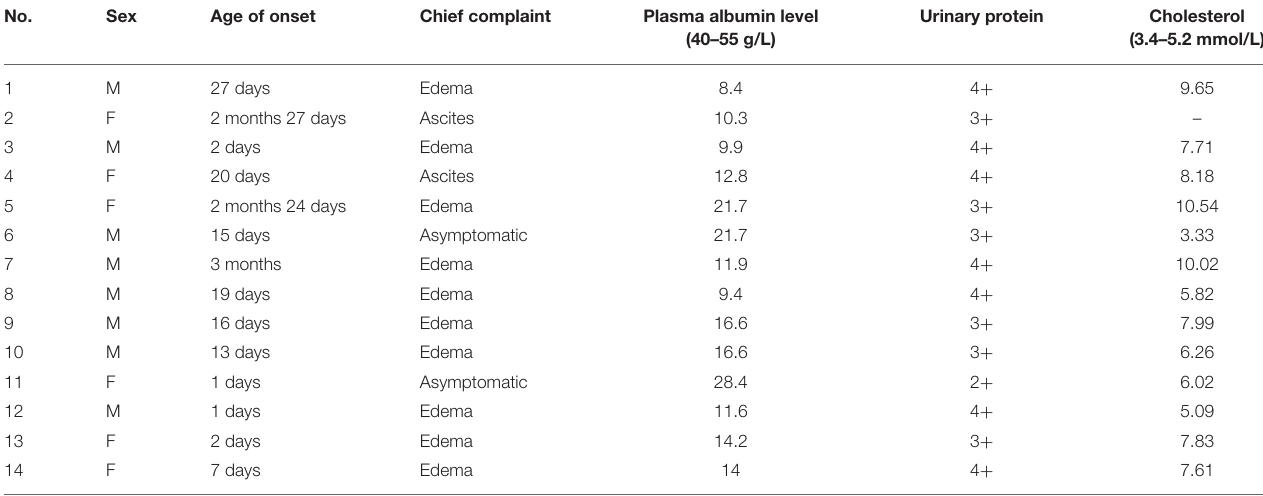
TABLE 1 | Onset conditions of 14